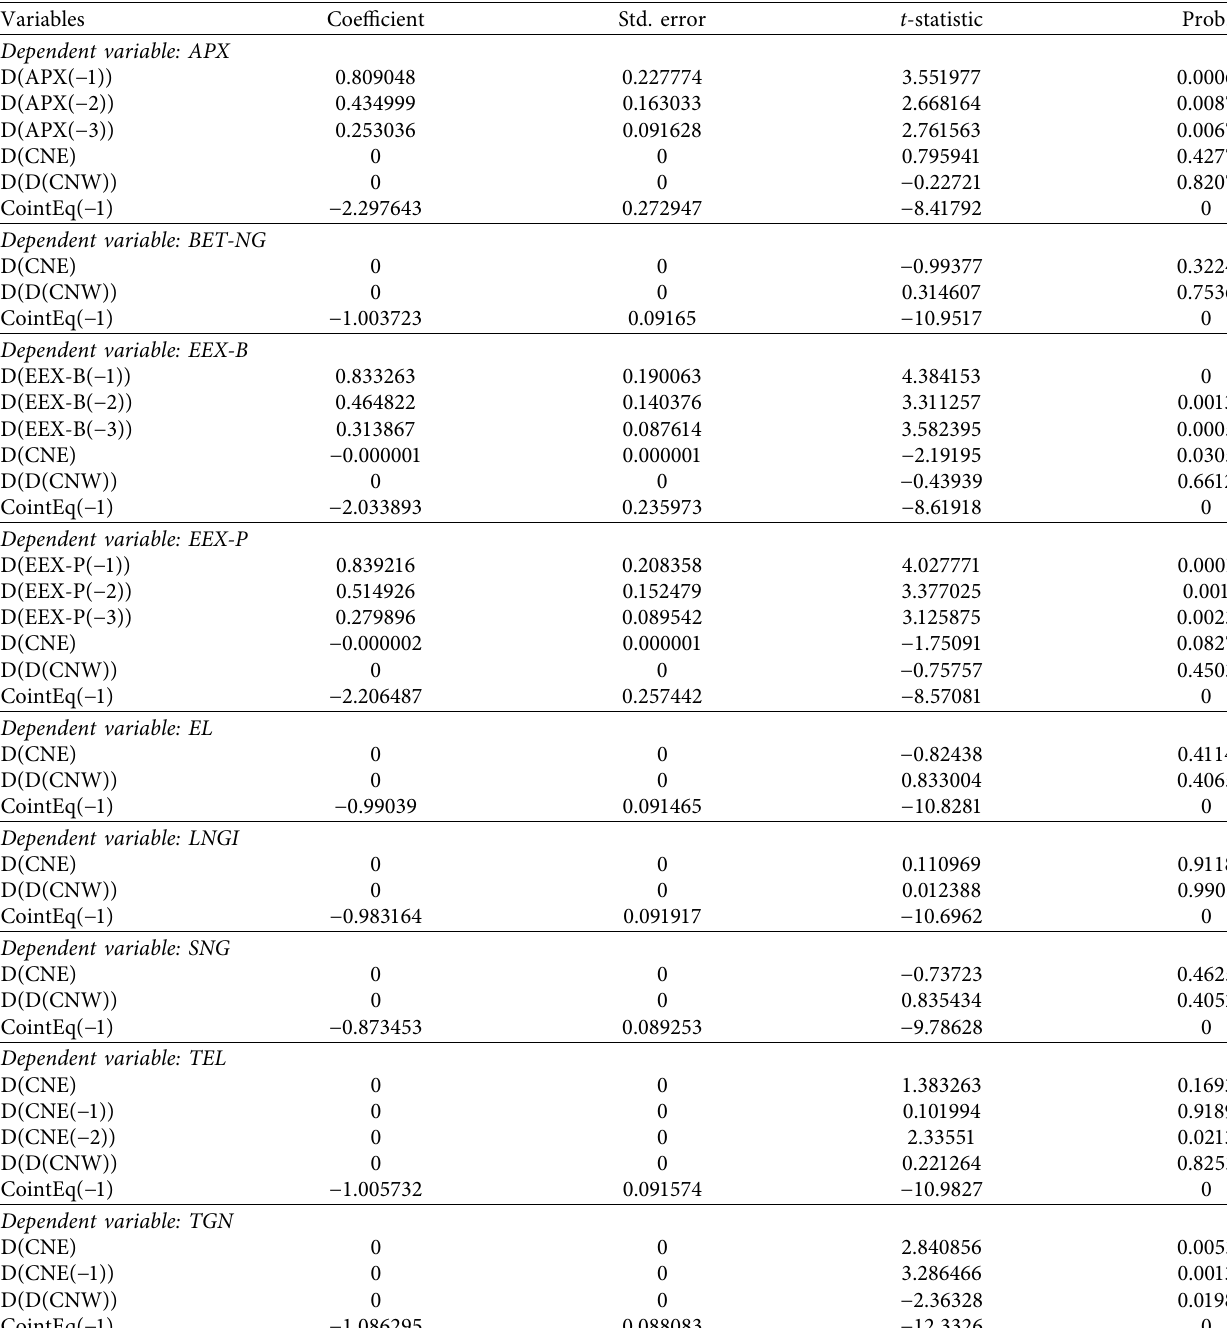
Table 10: ARDL cointegrating and short-term